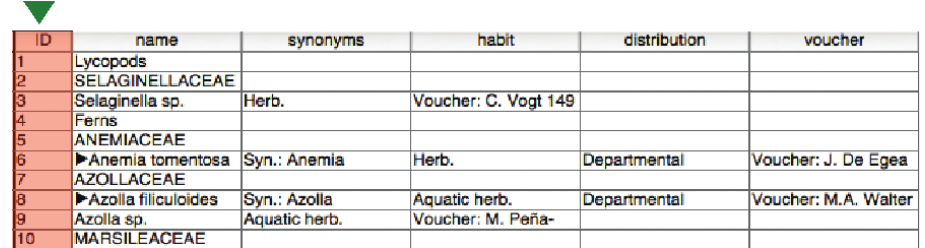
Figure 3. An updated database with final column titles and unique identifier added for each